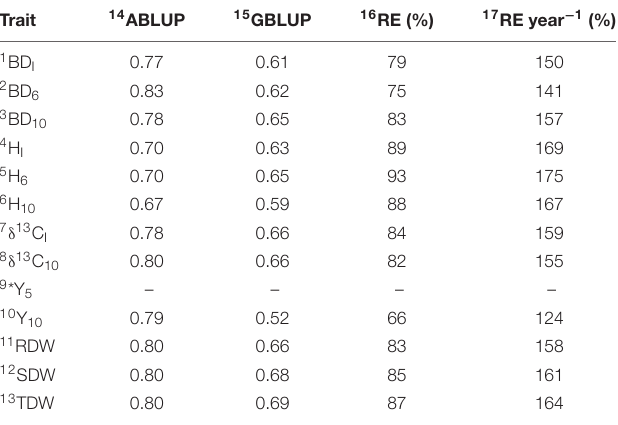
TABLE 3 | Accuracy of breeding values from single trait pedigree-based model, single trait genomic based model (10-fold cross-validation), relative efficiency of genomic selection (GBLUP) over quantitative genetic (ABULP) selection, and the relative efficiency per year.